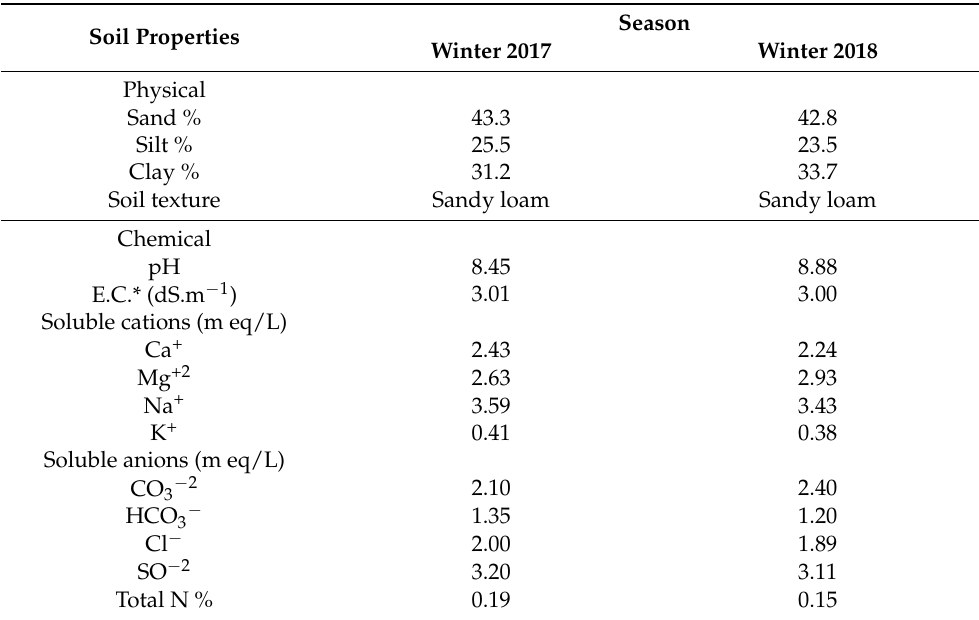
Table 9. Physical and chemical properties of the experimental soil of the two growing seasons, 2017 and